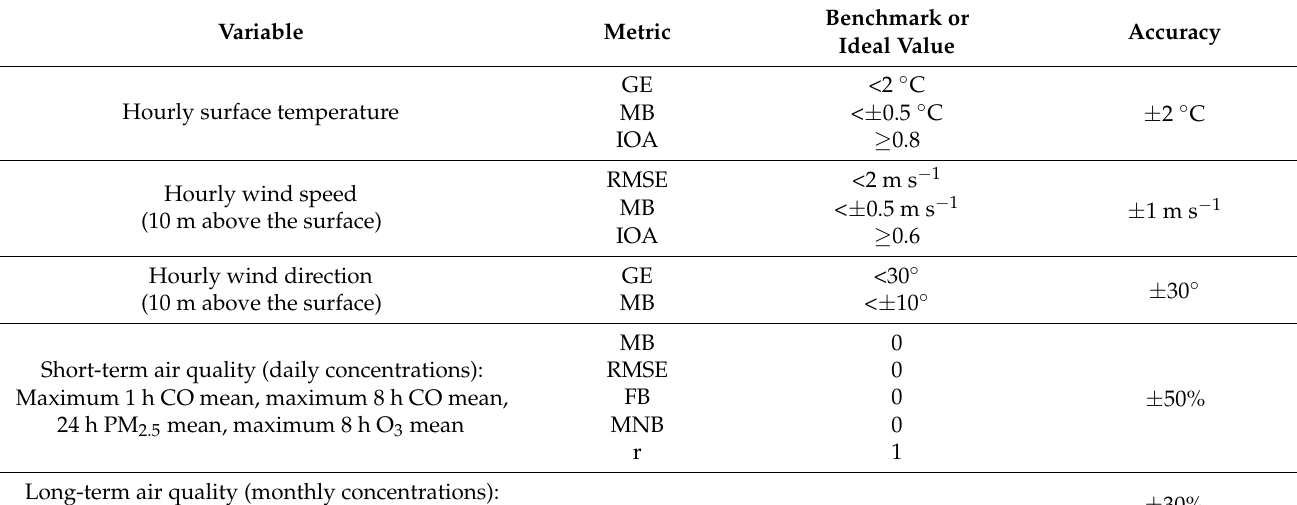
Table 4. Metrics for modeling meteorological and air quality variables [39,40].